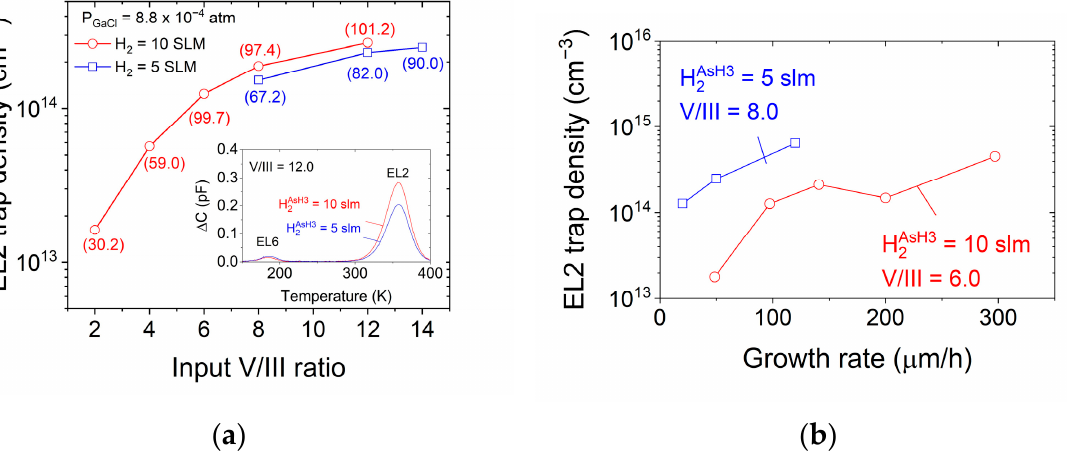
Figure 4. EL2 trap density in n -GaAs as a function of ( a ) input V/III ratio and ( b ) growth rate. The values in brackets indicate the growth rate for each condition. The inset of ( a ) shows the deep-level transient spectroscopy (DLTS) spectra of samples whose n -GaAs layers were fabricated at V/III = 12 under different H AsH 3 flow rates of 5 and 10 2